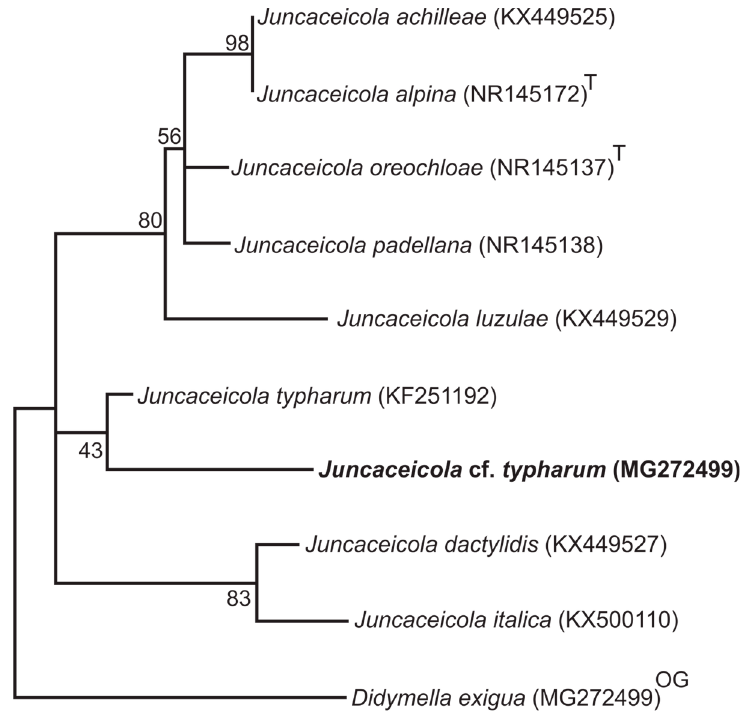
Figure 3. ML bootstrap tree showing the relationship among Deschampsia antarctica endophytic fungus ( Juncaceicola cf. typharum ) and other fungal sequences belonging to the Juncaceicola genus, following BLAST analysis. The tree was constructed using GenBank data based on rDNA (ITS1-ITS4) fragment sequence using MEGA program version 7 with a maximum likelihood method (bootstrap values are shown at nodes). The tree is rooted to Didymella exigua (CBS 183.55). The sequences of type species are indicated as superscript T.